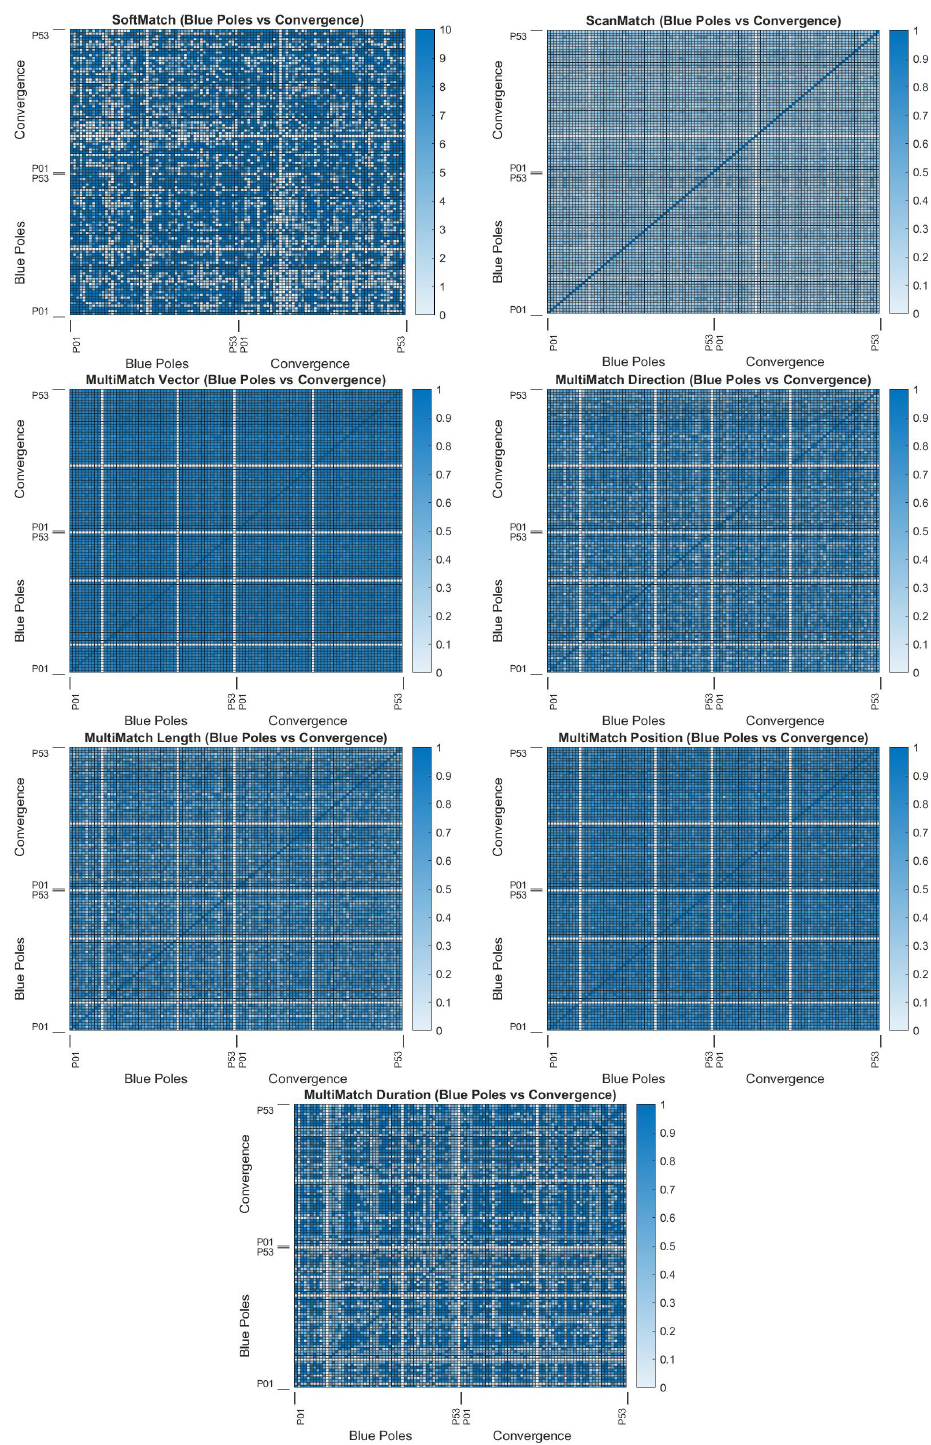
Figure A2. SoftMatch, ScanMatch, and MultiMatch heatmaps for empirical evaluation. Stimuli matched are Jackson Pollock’s Blue Poles (1952) and Jackson Pollock’s Convergence